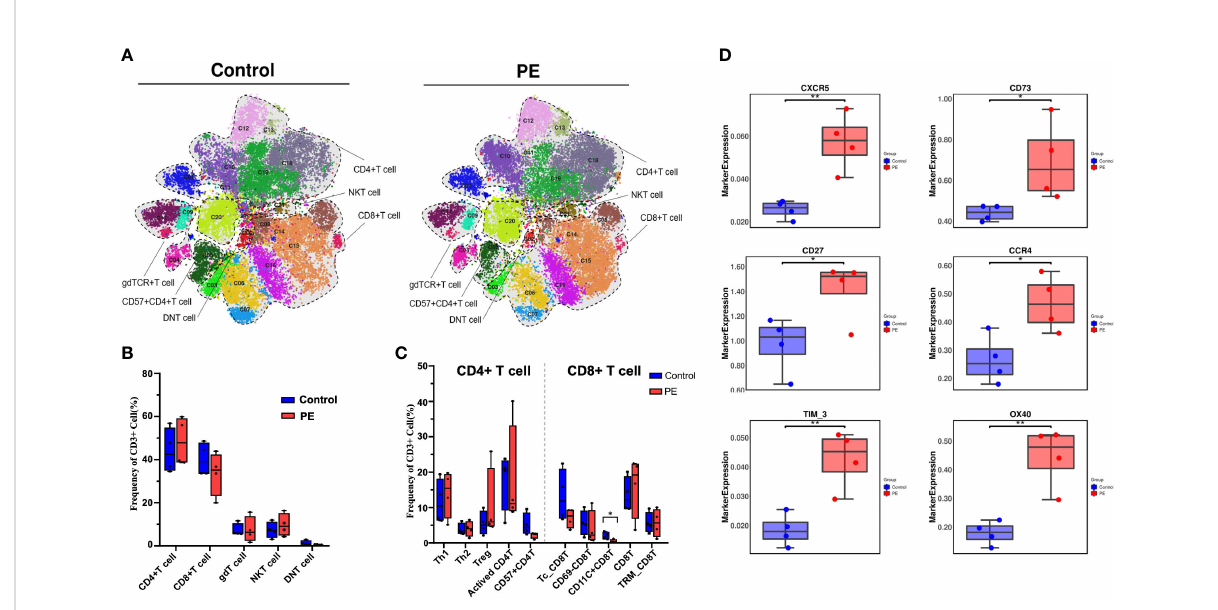
FIGURE 3 T cells were further selected and reclustered to show the alteration of T-cell subsets in PE patients, and the CD11c+CD8+ T-cell subset was signi fi cantly reduced in PE. (A) t-SNE plot of 21 clusters of CD3+ T cells from the PE and control groups that were merged into fi ve superclusters, namely, CD4+ T cells, CD8+ T cells, gdT cells, DNT cells, and NKT cells. Each color represents a cluster, and each shaded area circled by the dashed line represents a subset. (B) Bar plot of the frequencies of T-cell superclusters is shown. (C) Bar plot of the frequencies of the subsets classi fi ed as CD8+ T cells and CD4+ T cells is shown. (D) The markers expressed in all T cells that differed signi fi cantly in the PE and control groups. The blue bar and red bar in panels B and C denote the control and PE groups, respectively. * stands for p-value <0.01. ** stands for p-value